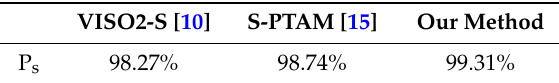
Table 5. Comparison of robustness